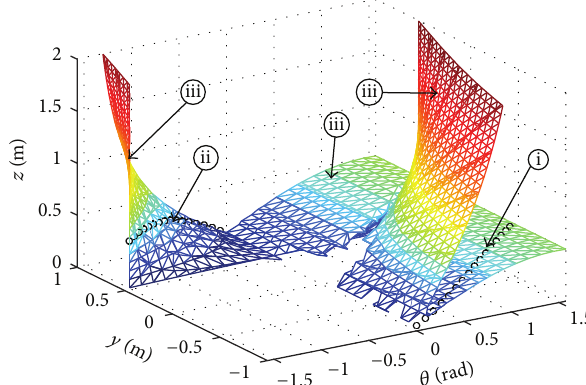
Figure 2: Input workspace of the harvester with 𝐿 = 1 m and 𝐷 = 0.1